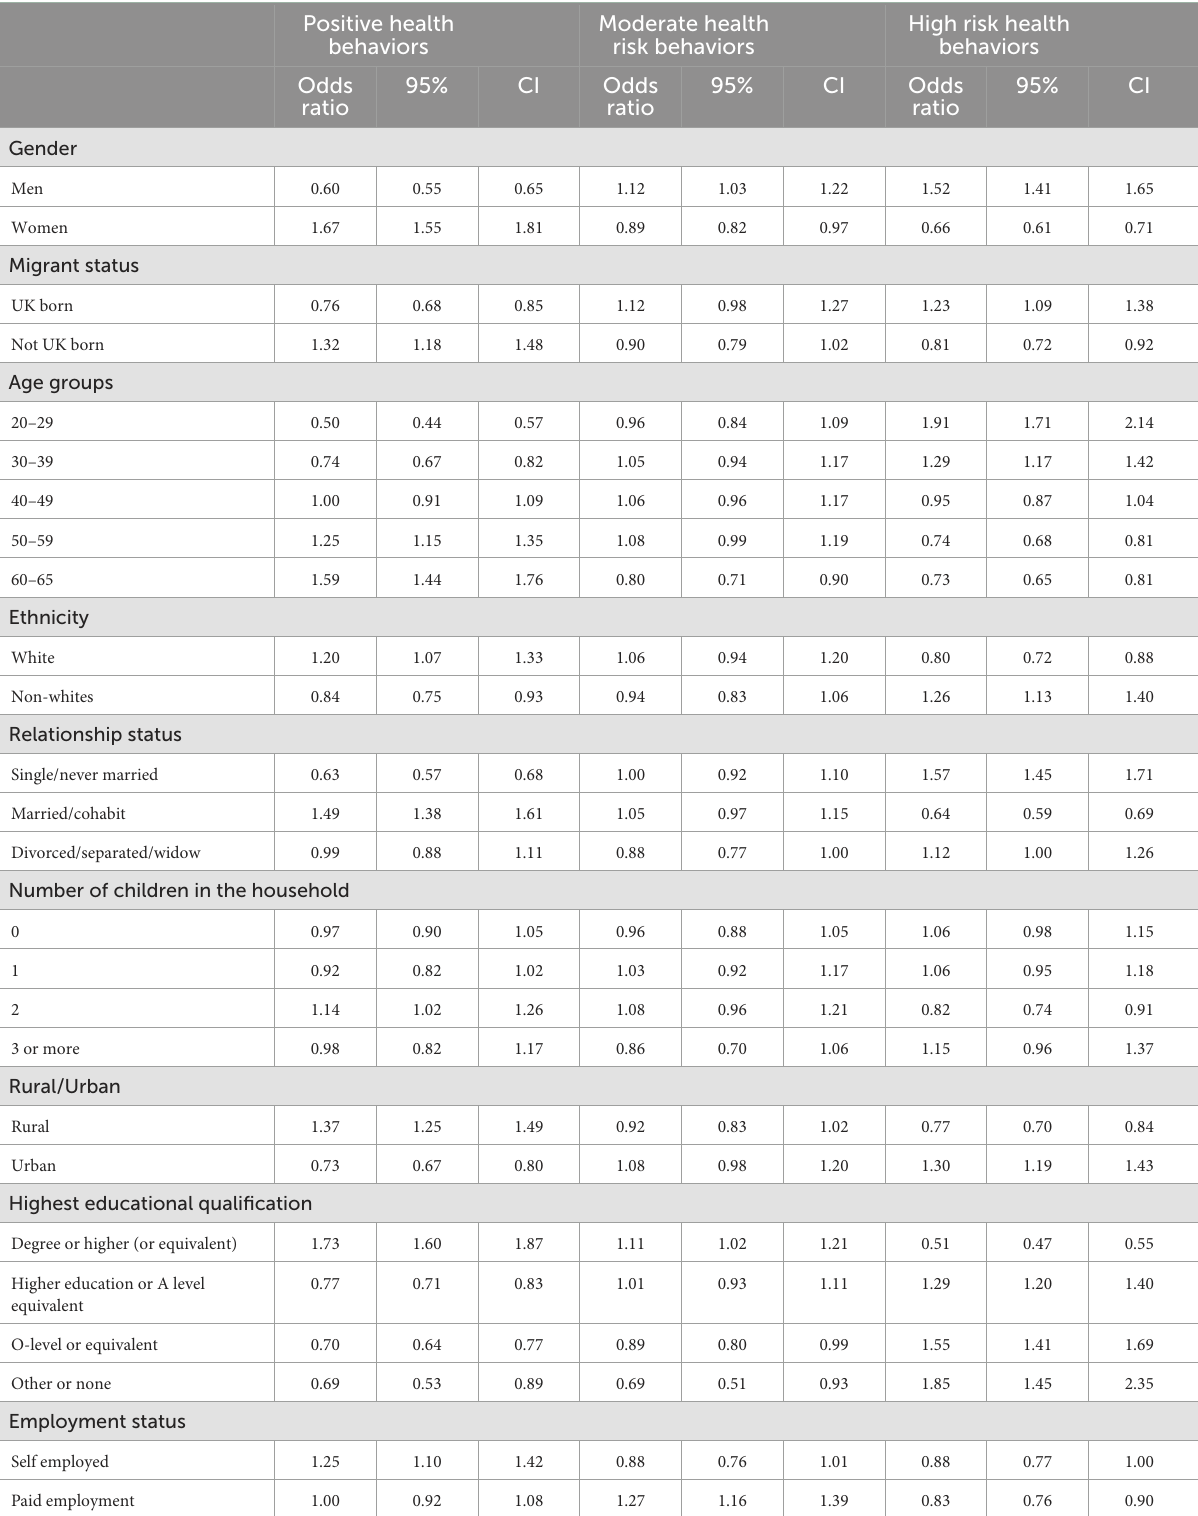
TABLE 2 Sociodemographic indicators and latent clusters